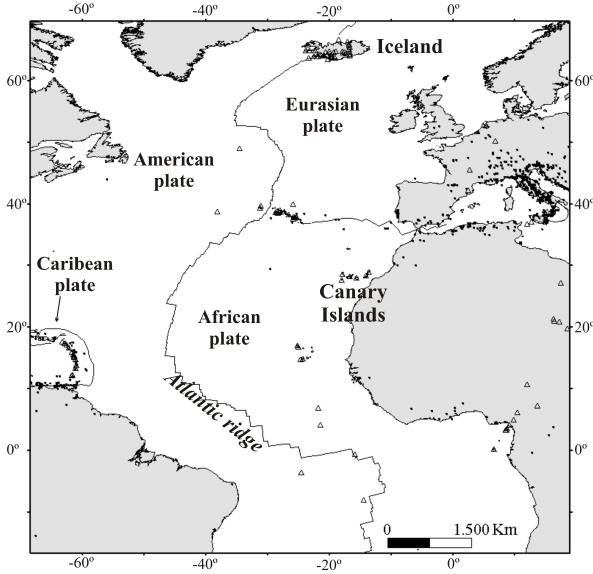
Fig. 1. Volcano-tectonic settings of Iceland and the Canary Islands.